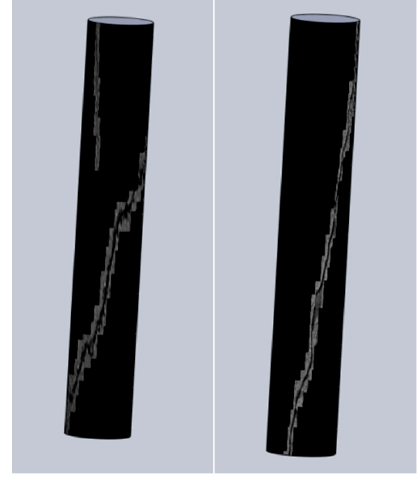
Figure 15. The resultant renderings.